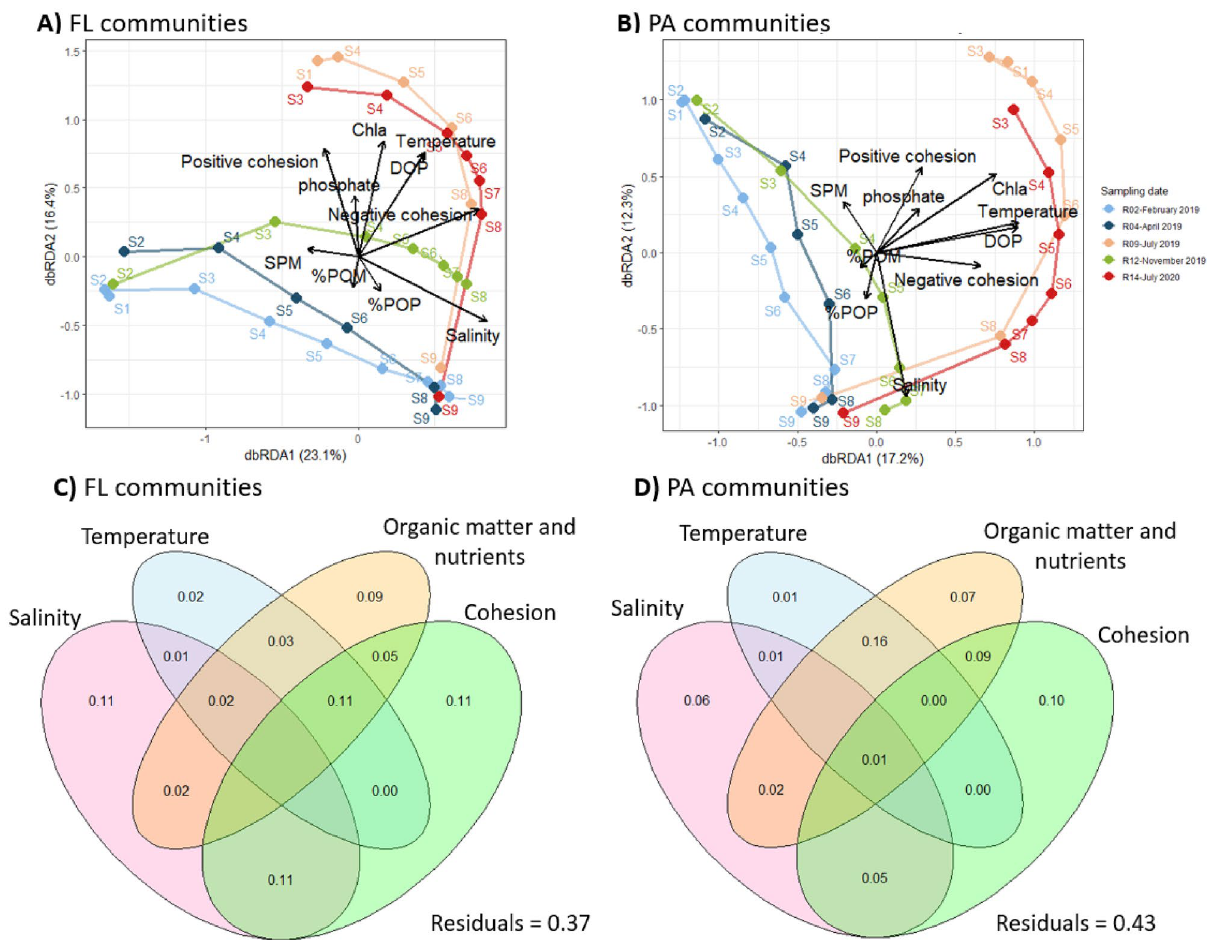
Figure 7. Bray–Curtis-based dbRDA ( A, B ) and variance partitioning ( C, D ) of the Bray–Curtis dissimilarity for the FL ( A–C ) and PA ( B–D ) communities. ( A, B ) The lines link the different stations within one sampling time in their spatial order (S1–S9) (solid line: FL communities, dashed line: PA communities). It should be noted that the absolute value of negative cohesion was used so that the degree of negative correlation increases with the absolute value of negative cohesion. The sampling station is indicated for each sample. ( C, D ) Organic matter and nutrients regroup the variables SPM, %POM, Chl a , DOP and phosphate, while cohesion comprises both positive and negative cohesion. Negative R 2 values are not